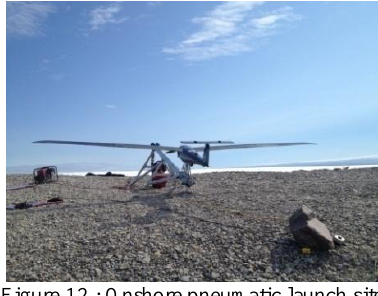
Figure 12 : Onshore pneumatic launch site